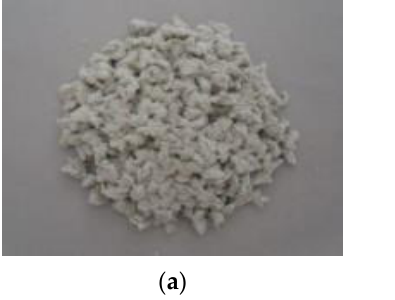
Figure 2. Lignin fiber: ( a ) Macro image; ( b ) Micro image. Table 1. Properties of short-cut basalt fiber.